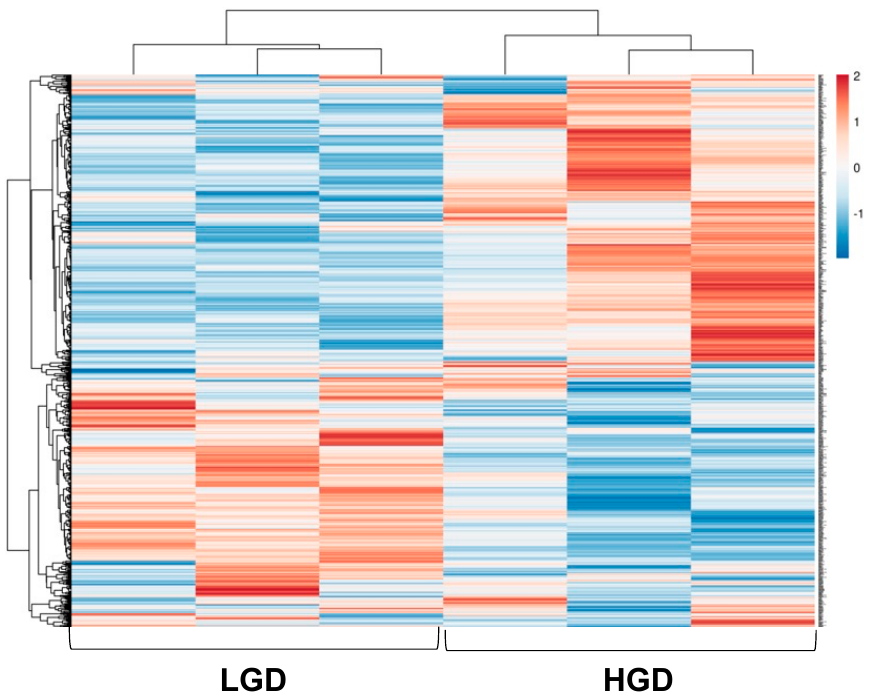
Figure 3. Hierarchical clustering of differentially expressed genes in hippocampal microvessels of the low glycemic diet (LGD) and the high glycemic diet (HGD). Upregulated genes are in red and downregulated genes are in blue. The data are shown for three biological replicates for each dietary group.